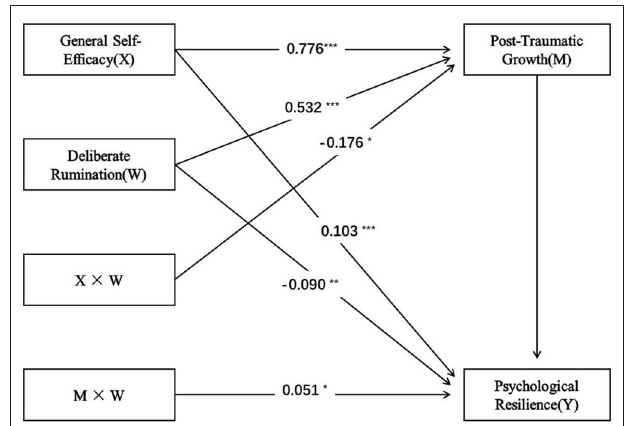
FIGURE 4 | The relationships between general self-efficacy, psychological resilience, posttraumatic growth and deliberate rumination. * p < 0.05; ** p < 0.01; *** p <